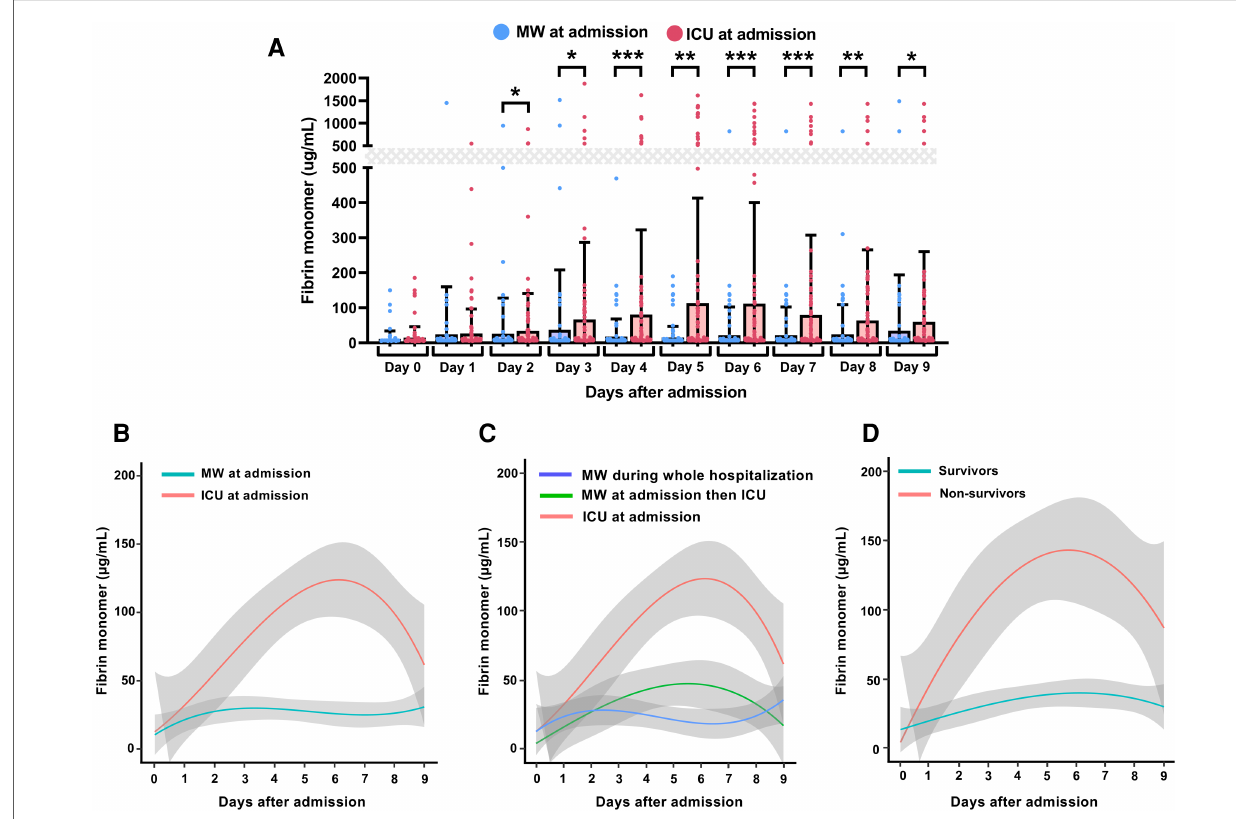
FIGURE 2 Daily monitoring of fi brin monomers levels and outcome predictions in hospitalized COVID-19 patients. For each group, the lines indicate the trendline of the mean FM levels measured daily during the fi rst 9 days of hospitalization and the gray-colored area denotes the 95% con fi dence interval. * p ≤ 0.05, ** p ≤ 0.01, *** p ≤ 0.001. ( A ) Comparison of FM levels during the fi rst 9 days of hospitalization. ( B ) Temporal trends of daily FM levels during the fi rst 9 days of hospitalization according to initial admission at hospital: medical ward (MW; blue Line) or intensive care unit (ICU; red line). ( C ) Temporal trends of daily FM levels during the fi rst 9 days of hospitalization according to the care pathway: MW during the whole hospitalization (blue line); MW at admission then referred to the ICU (green line); ICU at admission (red line). ( D ) Temporal trends of daily FM levels during the fi rst 9 days of hospitalization according to in- hospital mortality: survivors (blue line); non-survivors (red line).